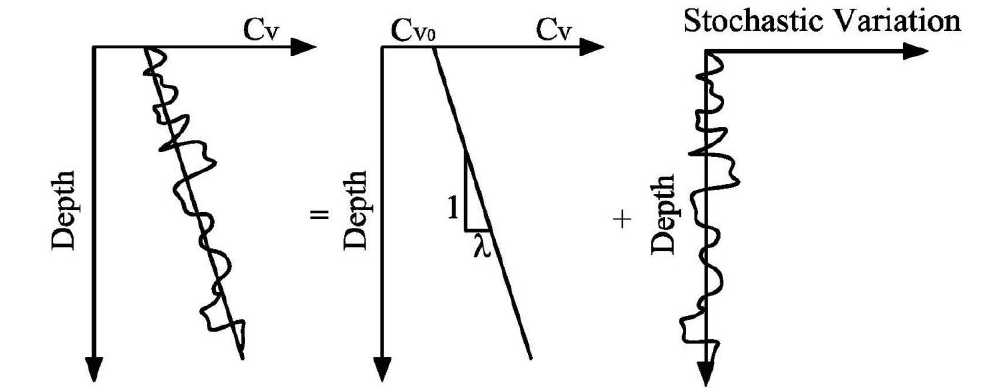
Fig. 1. Variation of soil cohesion with